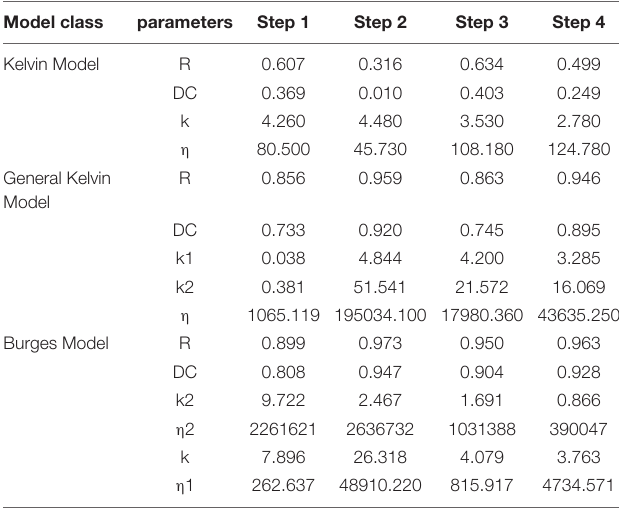
TABLE 5 | Goodness of fitting parameters for some of the creep models used in this